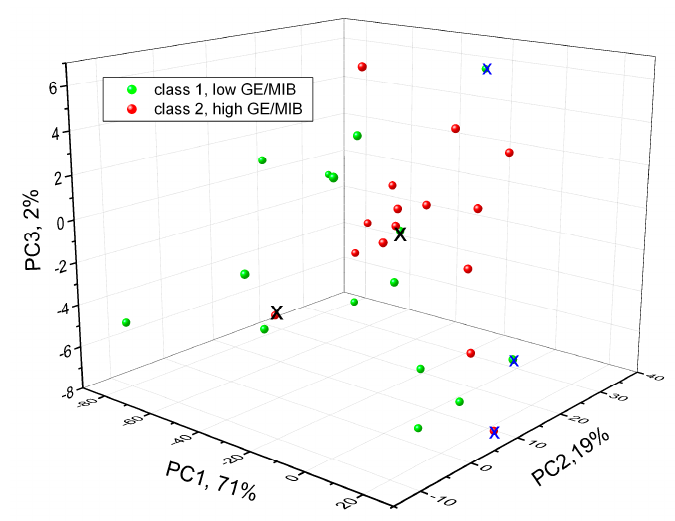
Figure 7. Three-dimensional (3D)-scores plot of PLS-DA GE / MIB detection in tap water by means of potentiometric E-tongue. X: misclassified samples; x: sample with no class attribution.